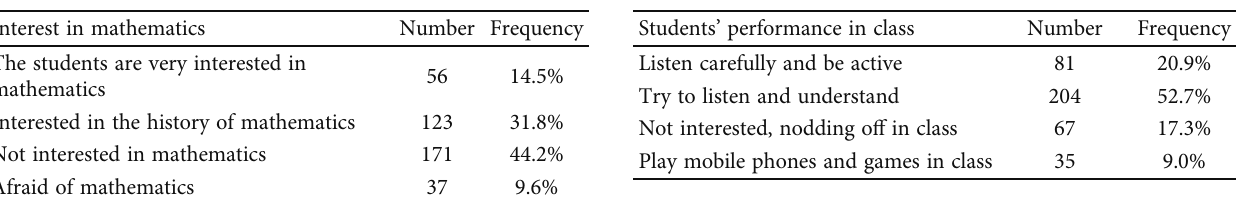
Table 2: Statistics of interest in mathematics learning. Table 3: Statistics of students ’ performance in